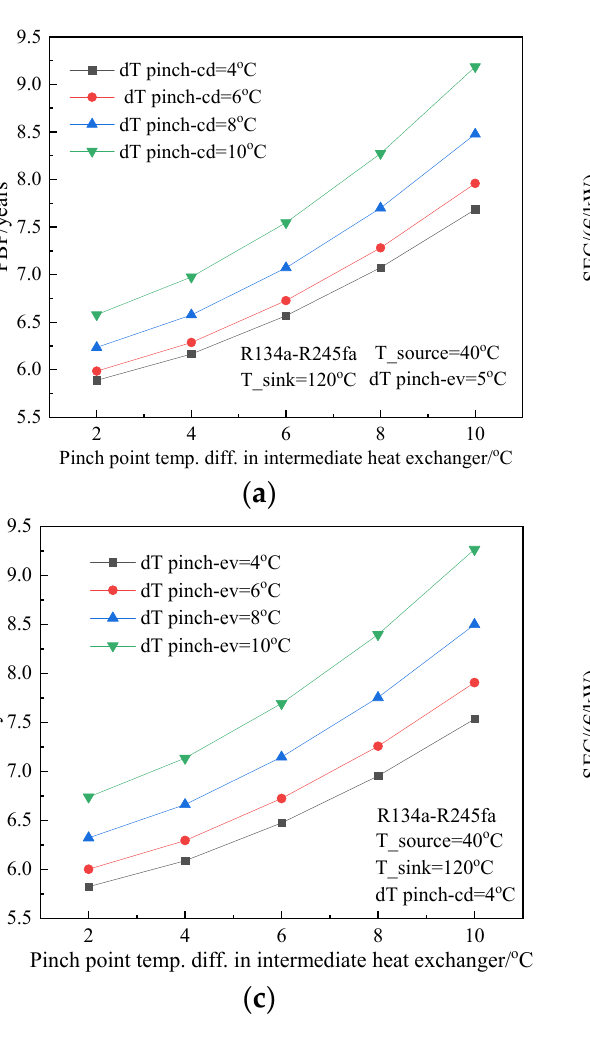
Figure 10. Effects of pinch point temperature difference on economic performance. ( a ) PBP change with pinch point temperature difference at condenser and intermediate heat exchanger. ( b ) SEC change with pinch point temperature difference at condenser and intermediate heat exchanger. ( c ) PBP change with pinch point temperature difference at evaporator and intermediate heat ex- changer. ( d ) SEC change with pinch point temperature difference at evaporator and intermediate heat exchanger.